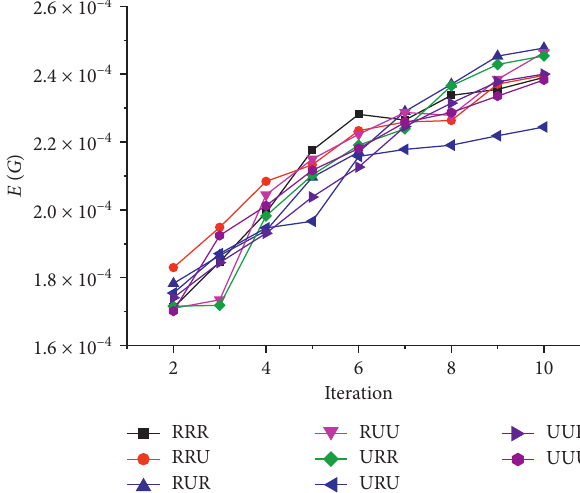
Figure 11: The change trends of network efficiency of different simulation scenarios.